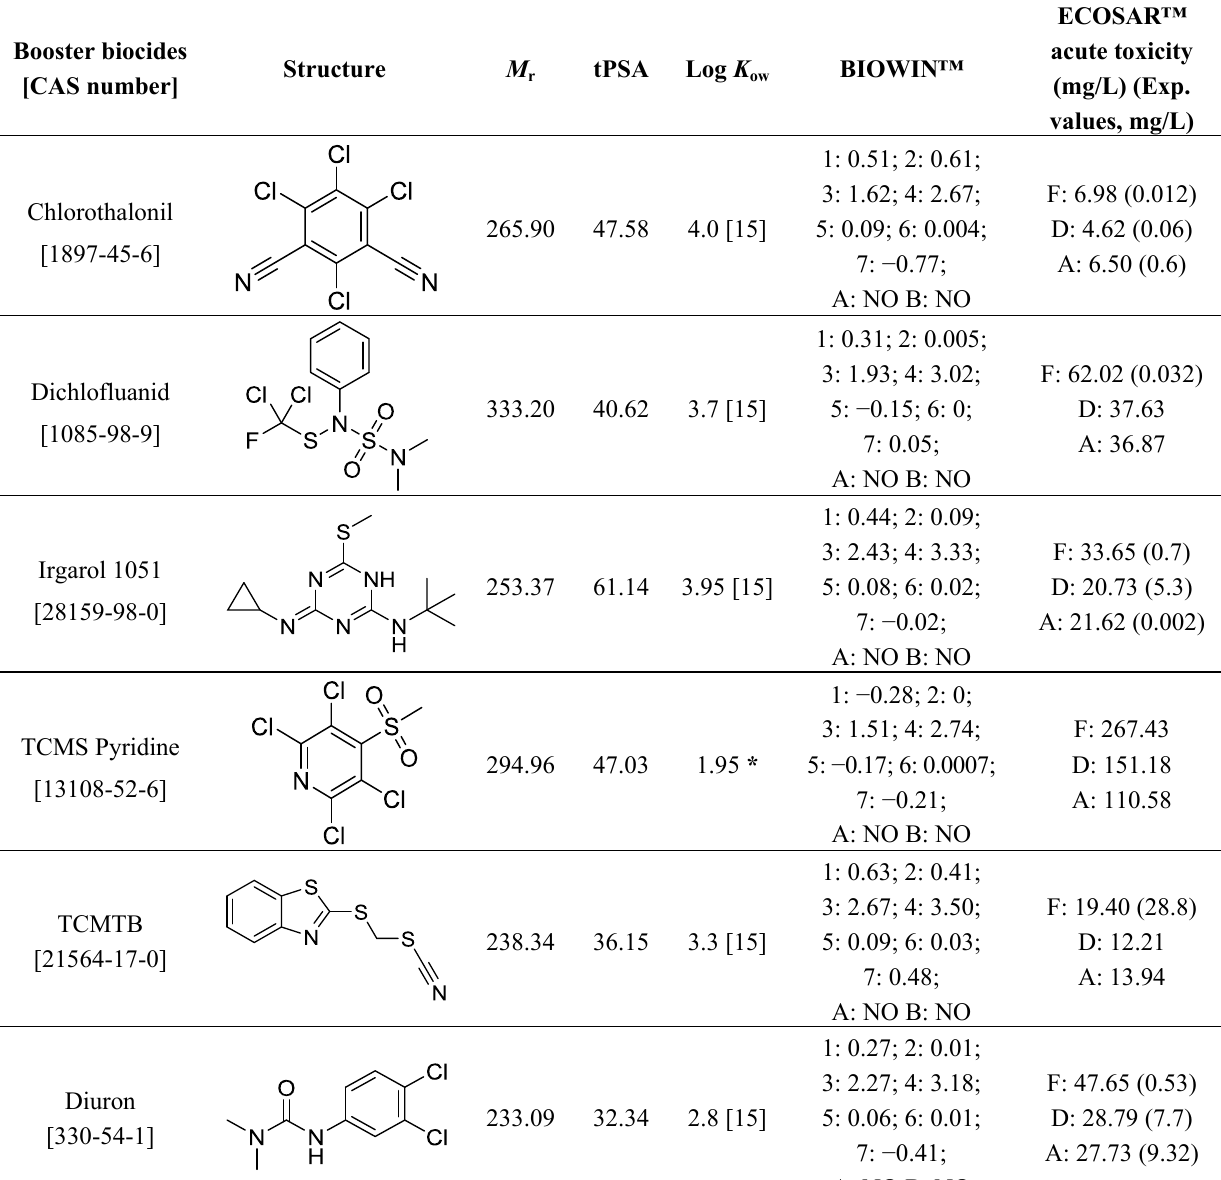
Table 1. Characterization of booster biocides. M = molecular weight; tPSA = total polar r surface area; Log K = log of water/octanol partition; * Log K values calculated using ow ow the log octanol-water partition coefficient calculation program KOWWIN™; ** Refers to calculations of the ligand (without the metal) for copper/zinc pyrithione and zineb. ** Log K of the ligand (without the metal) was estimated for copper pyrithione. ** tPSA ow of the ligand (without the metals) was estimated for copper/zinc pyrithione and zineb. Using BIOWIN™ (a biodegradation probability program) models: 1-linear, 2-non-linear, 3-ultimate, 4-primary, 5-linear Ministry of International Trade and Industry (MITI), 6-non-linear MITI, 7-anaerobic; Criteria A-model 2 or 6 > 0.5 and model 3 > 2.2; Criteria B-model 3 “weeks” or faster and model 5 > 0.5. Ecological Structure Activity Relationship programme (ECOSAR™): F = fish, D = daphnid, A = green algae. Experimental data were obtained from Material Safety Data Sheets (MSDS) unless specified